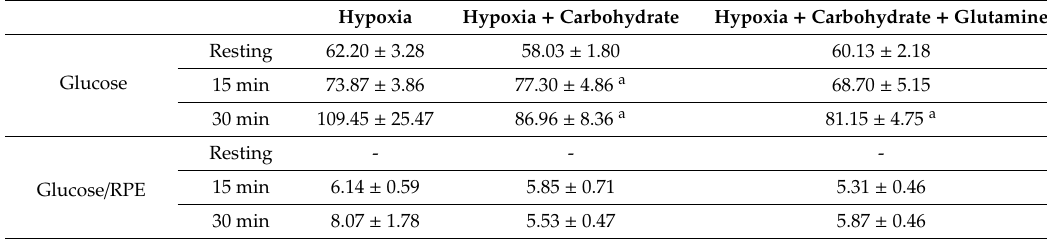
Table 1. Glucose concentration and glucose/RPE ratio.